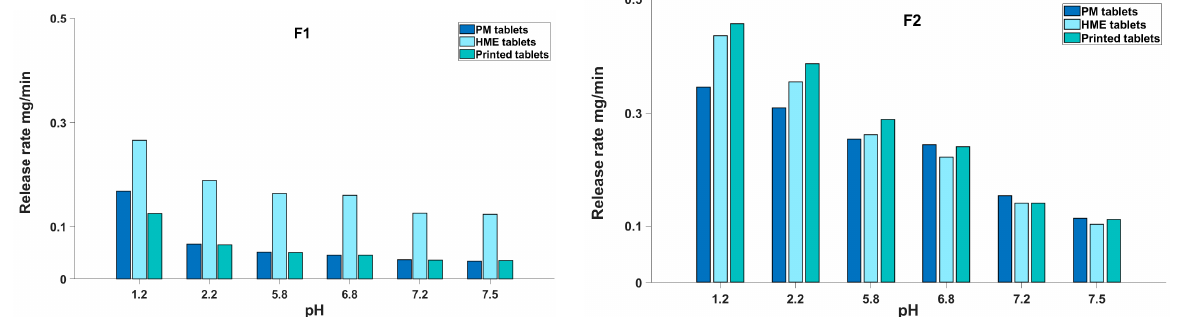
Figure 3. Bar charts comparing release rate at each pH medium during dissolution test at 10 dpm for PM, HME and printed tablets in both formulations.